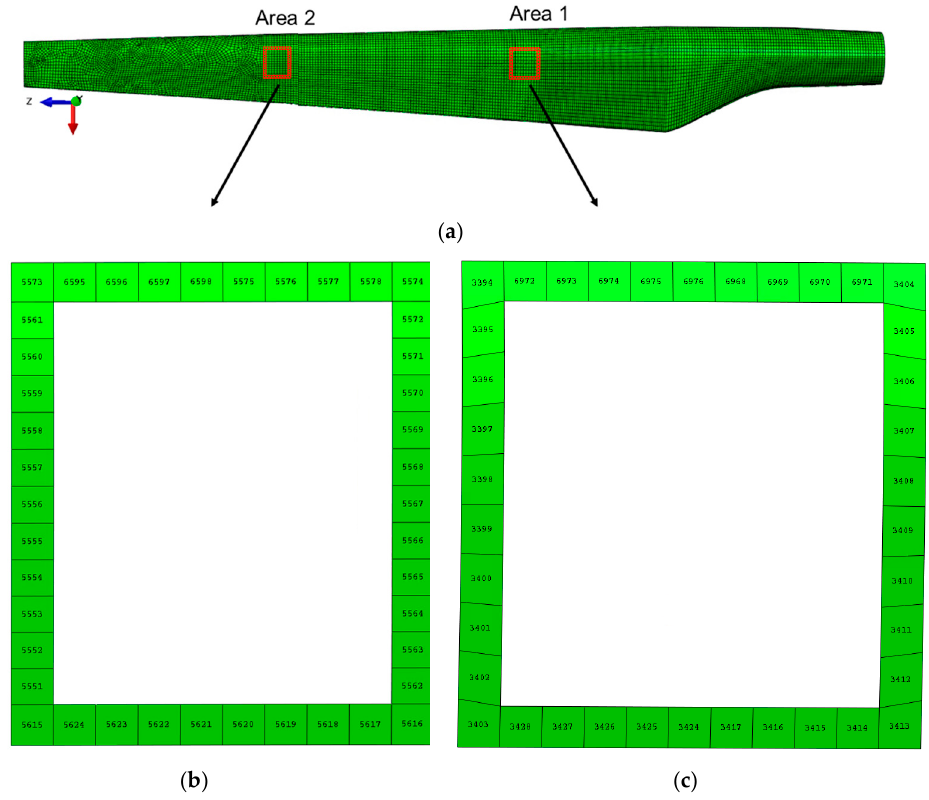
Figure 4. The elements on the contour of the delamination in the two areas: ( a ) the hypothetical two delaminated areas meshed in finite elements; ( b ) numbering of finite elements in the second delam- ination area; ( c ) numbering of finite elements in the first delamination